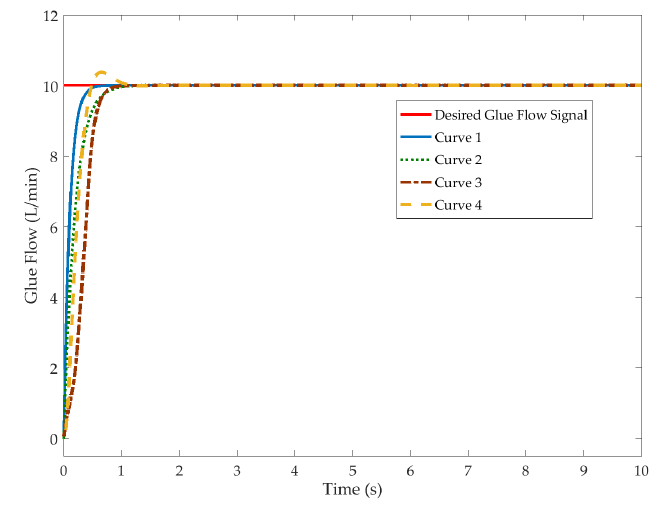
Figure 8. Time response of glue flow